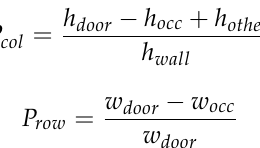
Figure 14. Schematic diagram of the parameters of Equations (10) and (11).